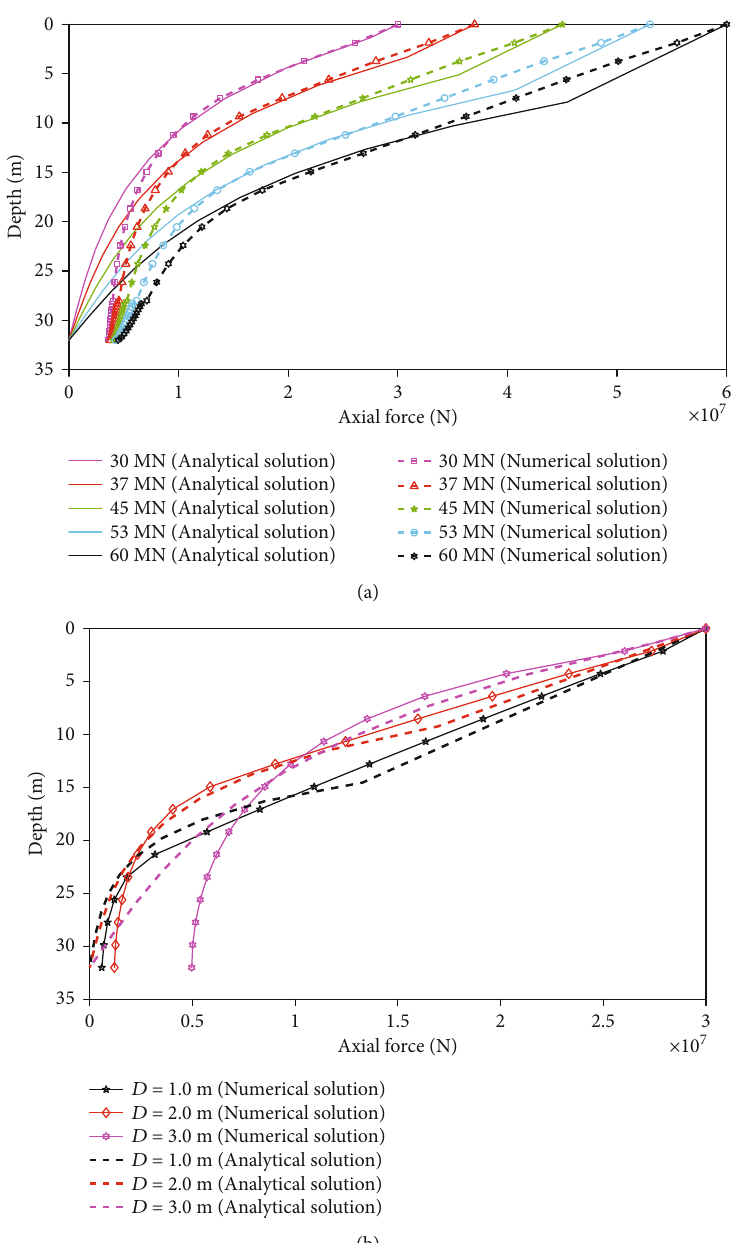
Figure 7: Veri fi cation in case of slope angle α = 30 ° : (a) the axial force distributions with di ff erent vertical load; (b) the axial force distributions in di ff erent diameter of pile with 32 MN vertical